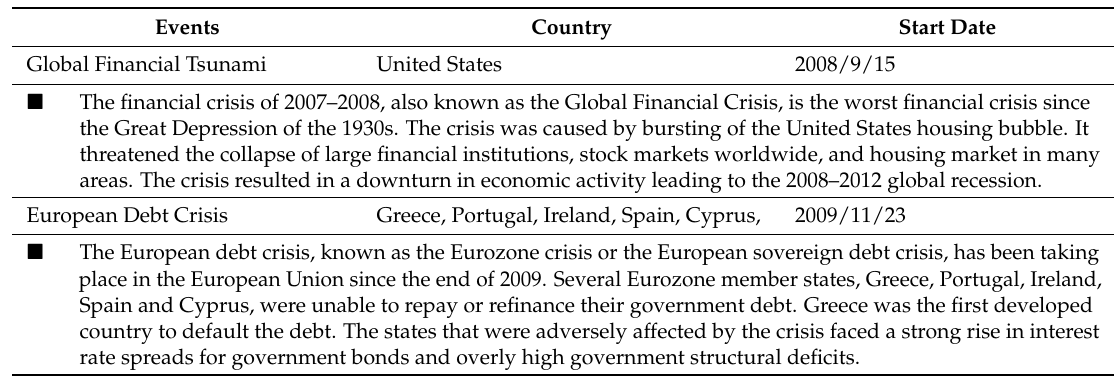
Table 2. Financial Crisis Events.